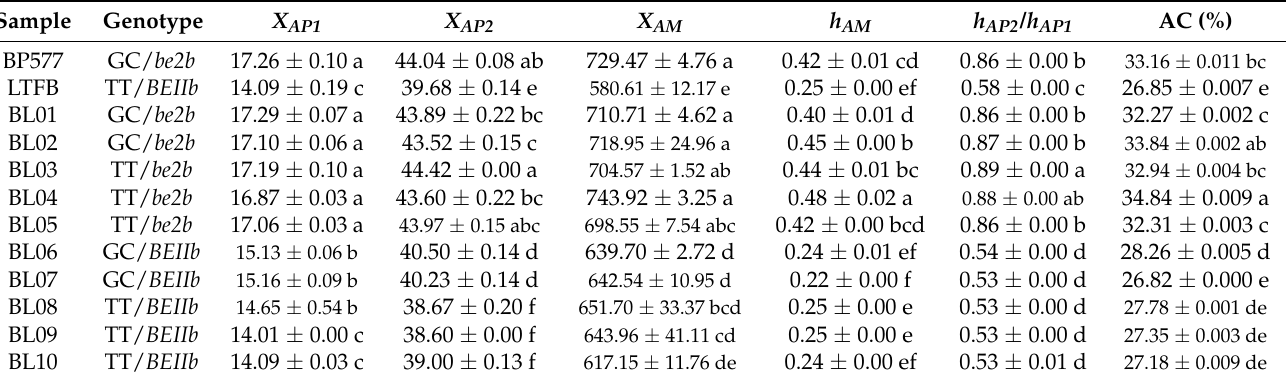
Figure 1. Genotyping of Wx , BEIIb, and SSIIa alleles in RILs. Table 1. Structural parameters of chain length distribution (CLD) of debranched starches obtained from SEC.